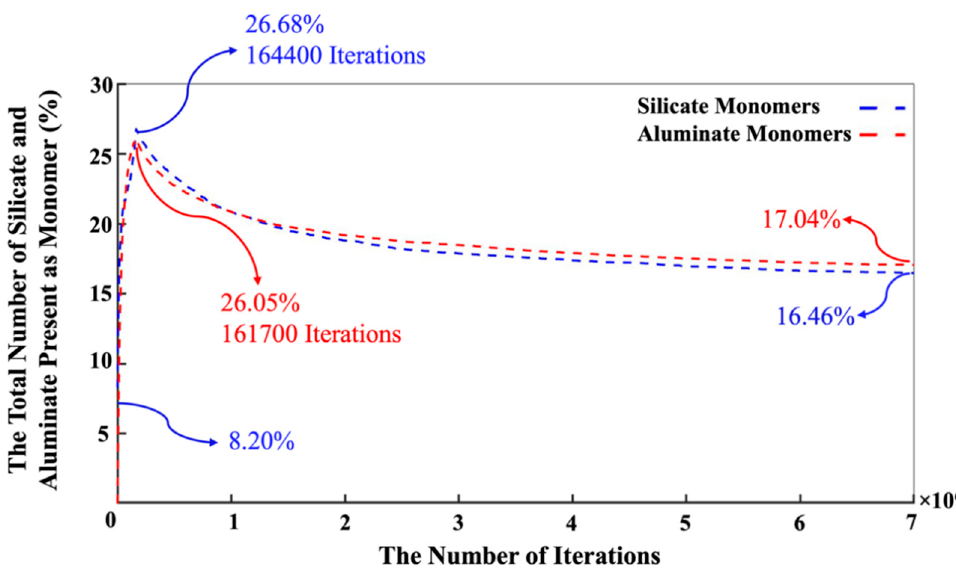
Figure 6. The change in the number of silicate and aluminate monomers present in the system during 7 million iterations. Metakaolinite particles are considered as monomers only when dissolved according to the dissolution process.